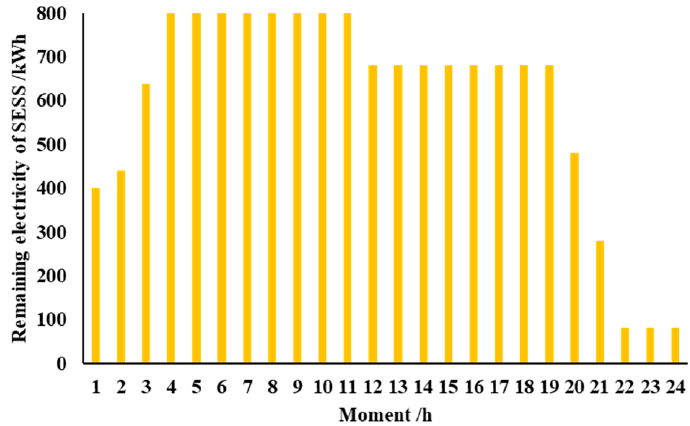
Figure 5. The final day-ahead economic scheduling scheme.